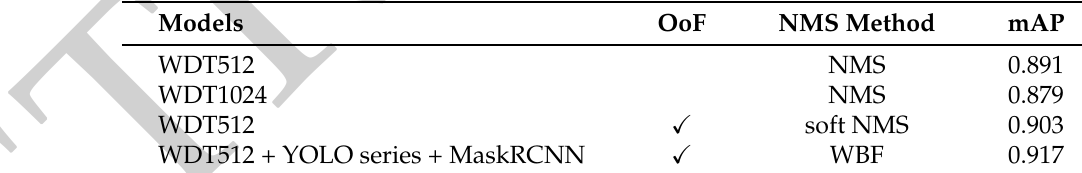
Table 4. Ablation experiment results of